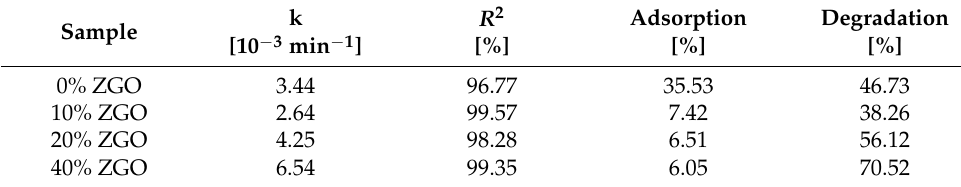
Table 2. Photocatalysis parameters of Zn 2 GeO 4 /g-C 3 N 4 nanocomposite.